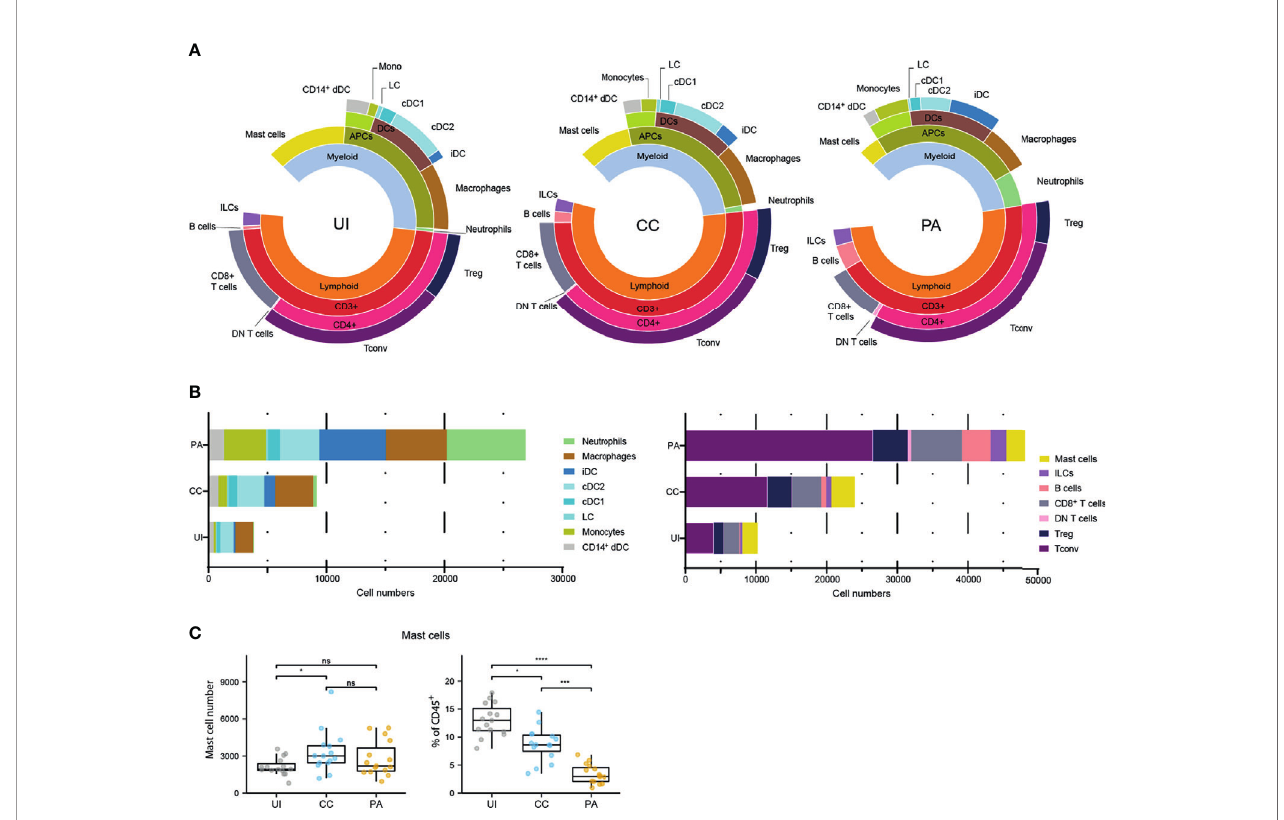
FIGURE 1 | Immune landscape of the early stages of acne. (A) Sunburst representation of the distributions and frequencies of the various cell subsets identi fi ed in the 3 stages. Results are expressed as percentages (means) of CD45 + cells. (B) Stacked bar graph representing the average number of the major immune cell populations identi fi ed with the two fl ow cytometry panels. (C) Data for mast cell number and percentages of CD45 + cells. Friedman test and Dunn ’ s post hoc tests *p < 0.05; ***p < 0.001; ****p < 0.0001; ns, not signi fi cant. The other cell number evolution between the 3 stages are provided Supplementary Figure 4